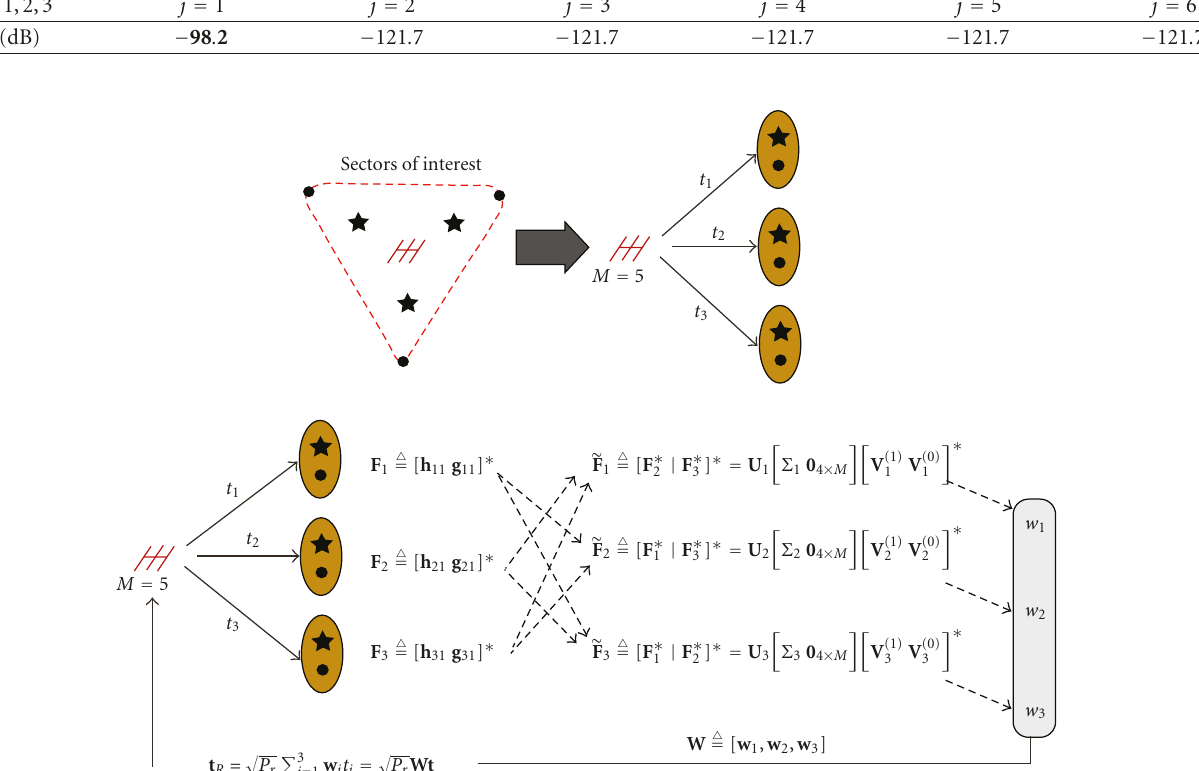
Figure 3: Operations of two-way block diagonalization at shared relay via SVD.